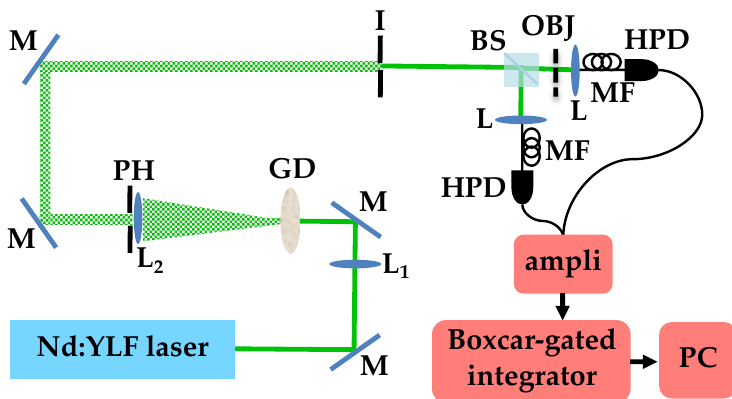
Figure 2. Sketch of the experimental setup. M: mirror; L 1 : 200 mm-focal-length lens; GD: rotating ground-glass disk; L 2 : 200 mm-focal-length lens; PH: pin-hole; I: variable iris; BS: balanced beam splitter; OBJ: object; L: achromatic doublet; MF: multi-mode optical fiber; HPD: hybrid